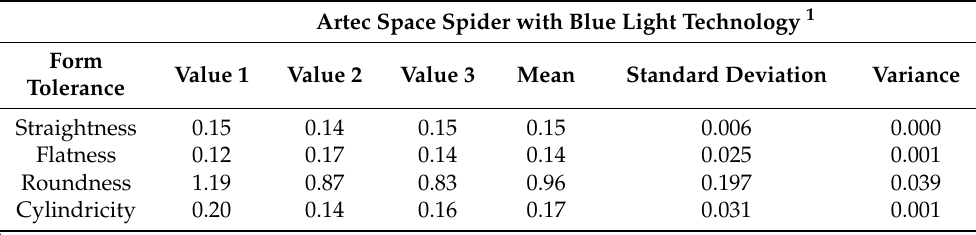
Table A3. Determined form tolerance values of different Lego bricks scanned by Artec Space Spider.